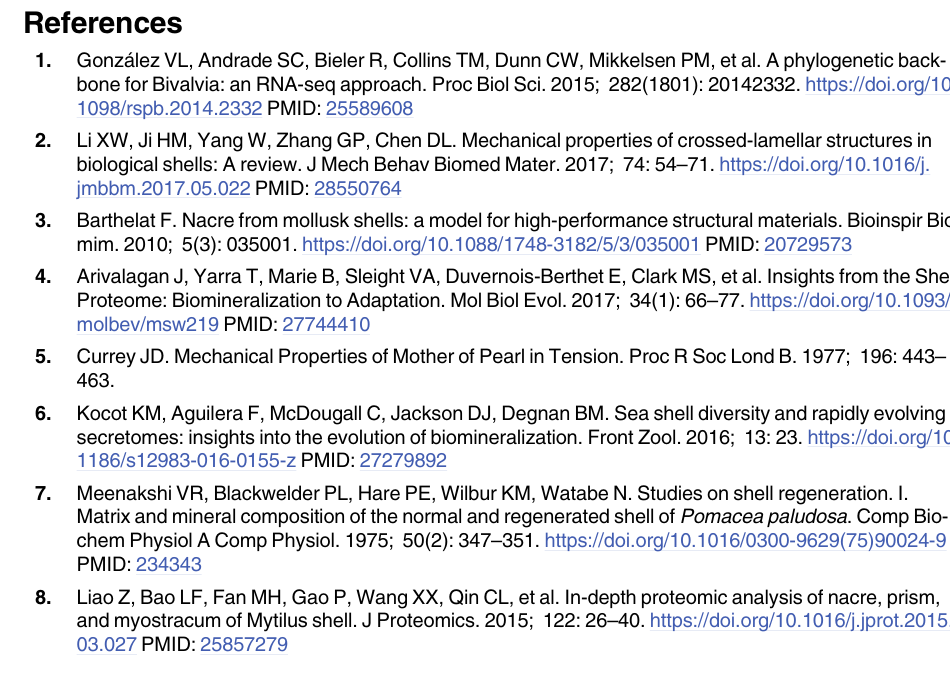
S2 Fig. Phylogenetic tree of WLP. The phylogenetic tree was constructed using MEGA 7.0 software with neighbor-joining method. Homologous included in construction of phyloge- netic tree were retrieved from NCBI nr database with high score using BLAST. The BLAST information of selected sequences are shown in S1 Table. S1 Table. BLAST results of WLP in NCBI nr database. S2 Table. Amino acid composition (mole percent) of